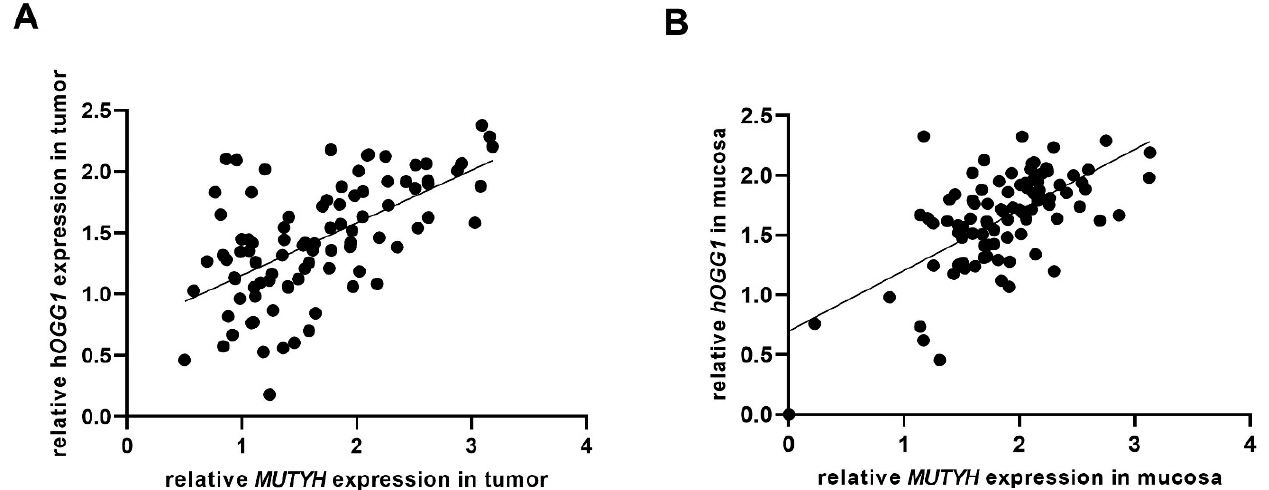
Figure 2. ( A , B ). MUTYH and hOGG1 relative gene expressions significantly correlated in both tumor (rho = 0.599, p < 0.001) and adjacent mucosa (rho = 0.638, p < 0.001; n = 91).